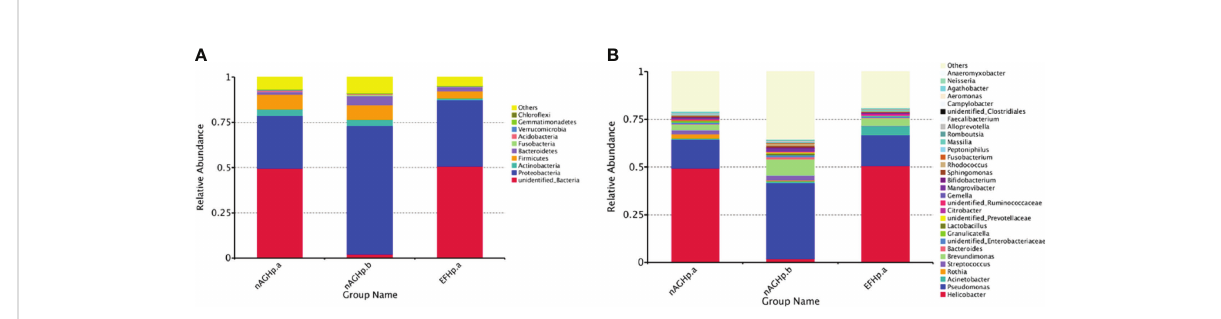
detailed in Figure S3. The results of FDR analysis of the KEGG pathway are detailed in Supplementary Material 1.